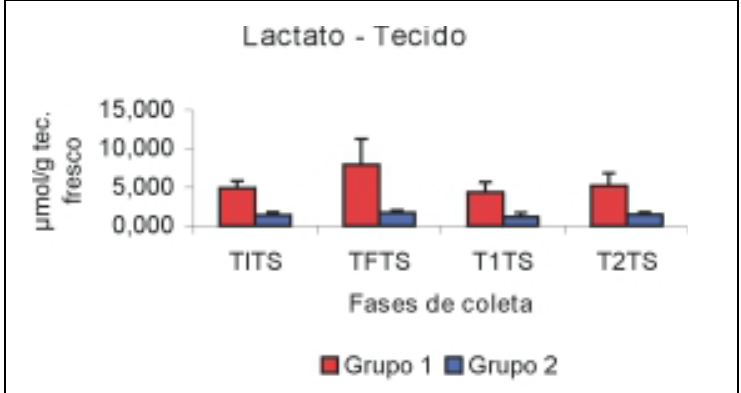
FIGURA 4 – Concentração de lactato no tecido